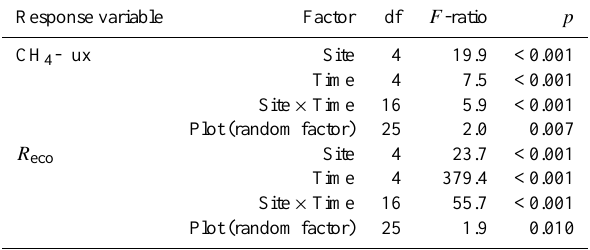
Table 2. Results from repeated-measures ANOVAs with the re- sponse variables CH 4 -flux and R eco , respectively, the fixed factors site and time and their interaction, and the random factor Plot. Gas fluxes were measured during April-November 2012 from six plots at two Suaeda salsa wetlands, two Phragmites australis wetlands and one rice paddy in the Liaohe Delta, Northeast China. All mea- surements from April, May and August were excluded from the analysis due to missing data from some